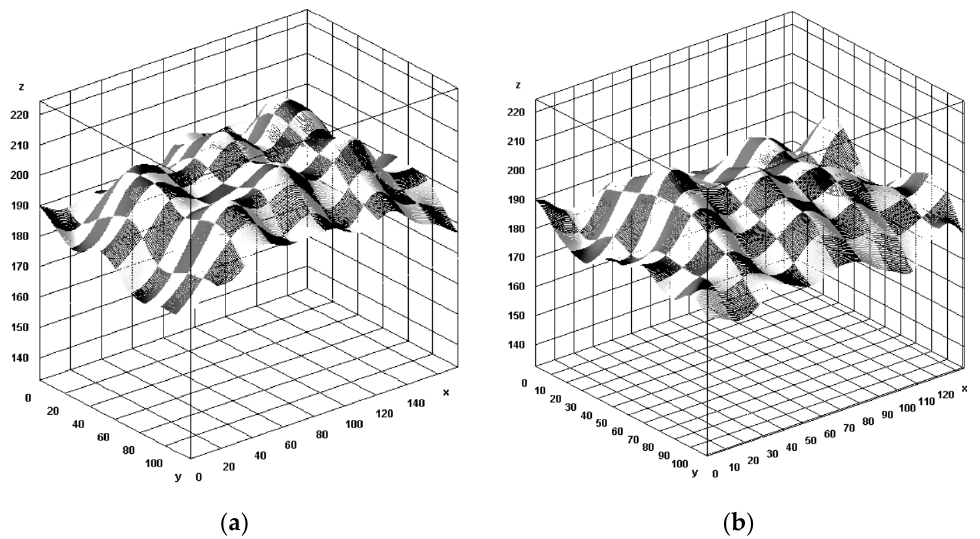
Figure 4. The use of 3D plots can make the images more visible: ( a ) 0.25 c/mm vertical; ( b ) 0.35 c/mm vertical. Units in pixels; averaging was performed to reduce the statistical noise.